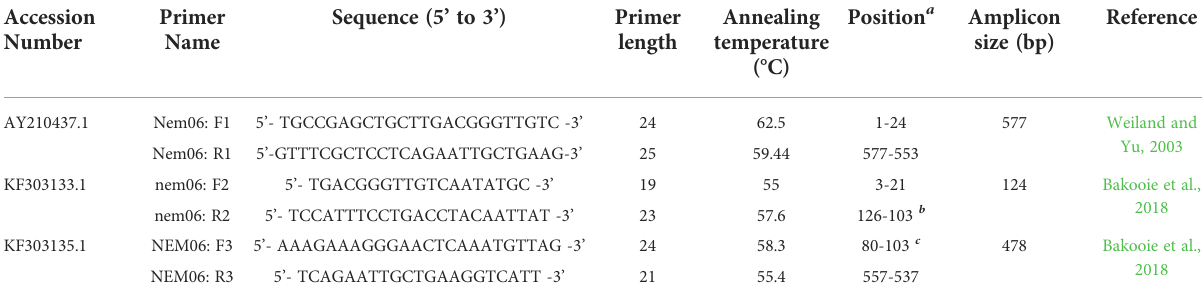
TABLE 3 Oligonucleotide sequences used for sugar beet resistant/susceptible genotyping to root-knot nematode Meloidogyne incognita